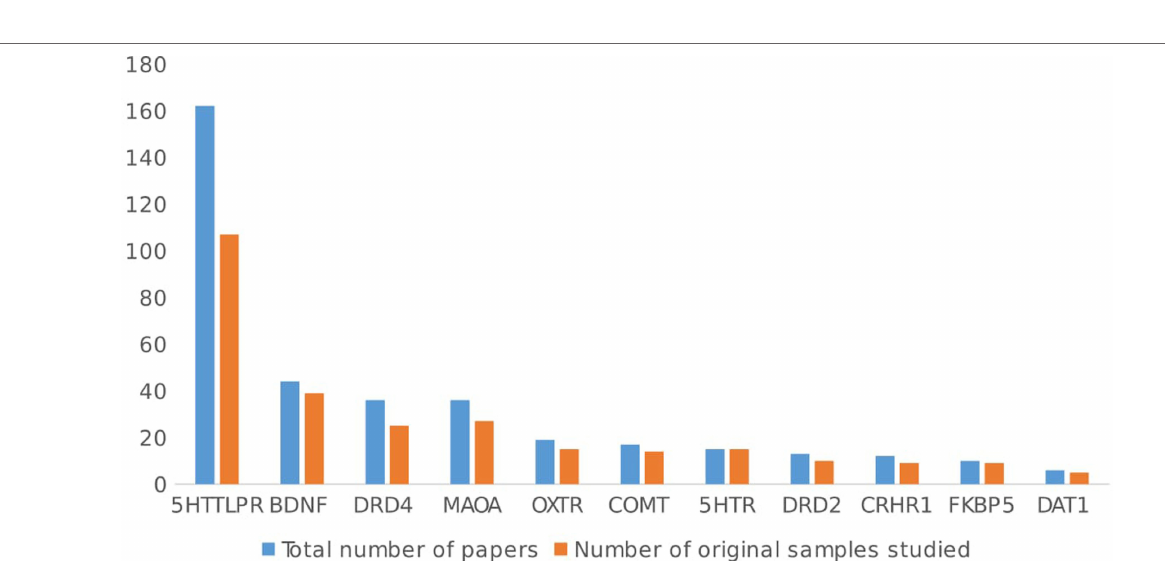
FiGURe 5 | World distribution of gene–environment interaction studies (samples and original